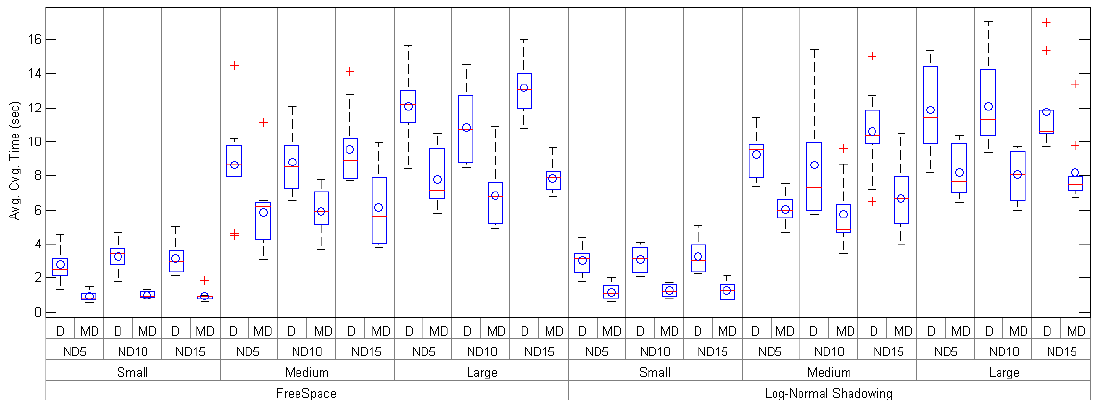
Figure 8. Average convergence time of Daral (D) and mDaral (MD) for small-, medium- and large-size scenarios under different propagation conditions and node densities (ND5, ND10 and